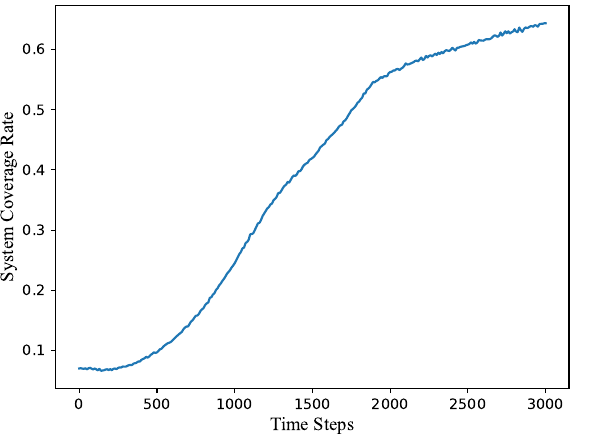
Figure 5. The variation of the system coverage rate as a function of the calculation time steps. In order to test the validation of the Monte Carlo algorithm on the 3D network coverage rate, Table 1 gives the final values of the coverage rate at the 3000th time step, for three independent running cases, based on different number of test points p t . It can be seen that, under a different number of test points, the coverage rate does not change much for all three cases. Those very small differences are due to the difference of initial distribution and the calculation error of the Monte Carlo algorithm itself. We think that these small differences can be ignored and the Monte Carlo algorithm does present a good evaluation for the calculation of the system